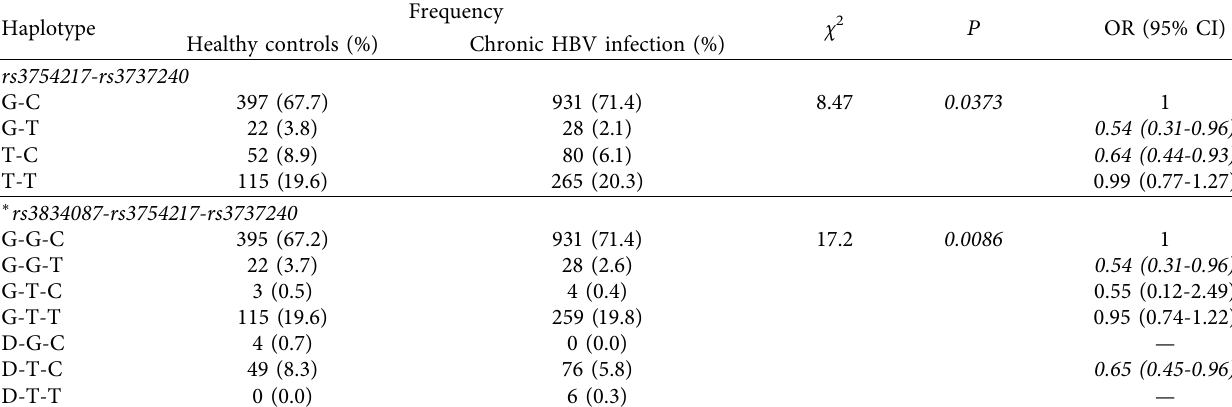
Table 6: Haplotype distributions between healthy controls and chronic HBV infection patients.